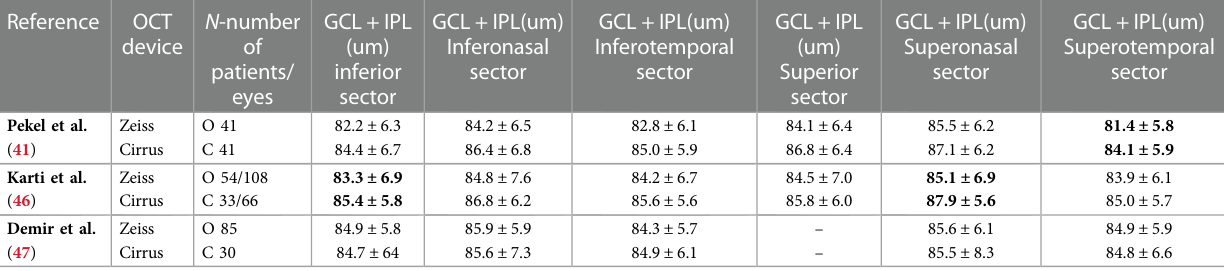
TABLE 2 Summary of reported values of OCT GCL+IPL in obese children and adolescents (mean±SD) in literature.